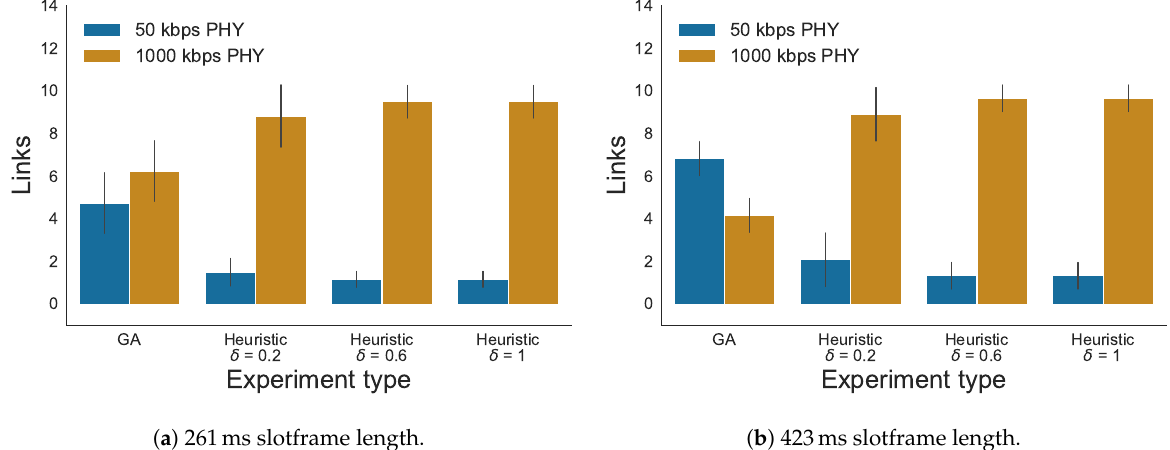
Figure 12. Average number of PHY allocations per iteration for the GA scheduler and the heuristic with different δ values, for scenario 2. The error bars in the figures represent the standard